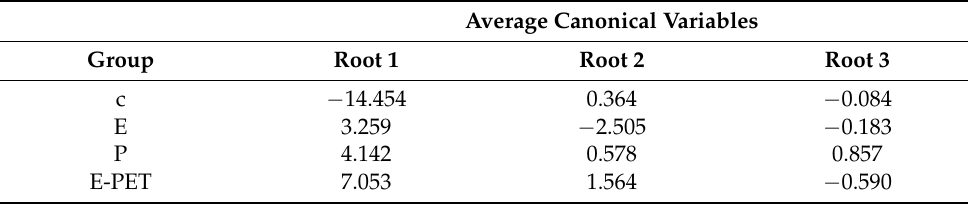
Table 7. Average canonical variables of the discriminant functions.